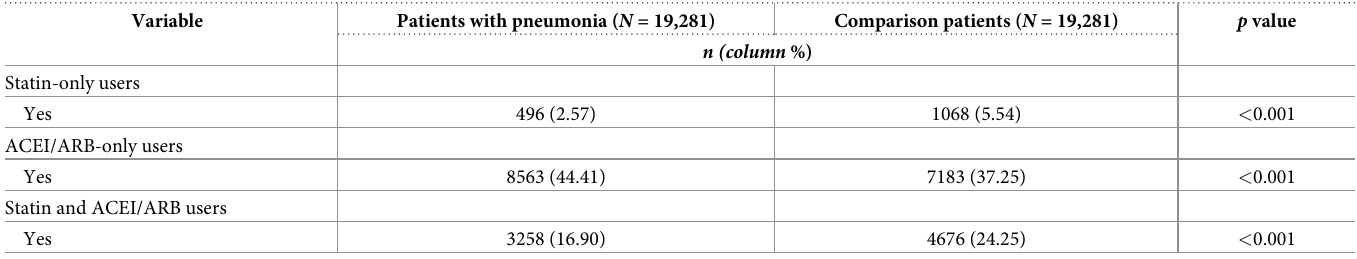
Table 2. Prevalence of statin and angiotensin-converting enzyme inhibitor (ACEI)/ angiotensin II receptor blocker (ARB) users in the pneumonia and control groups.